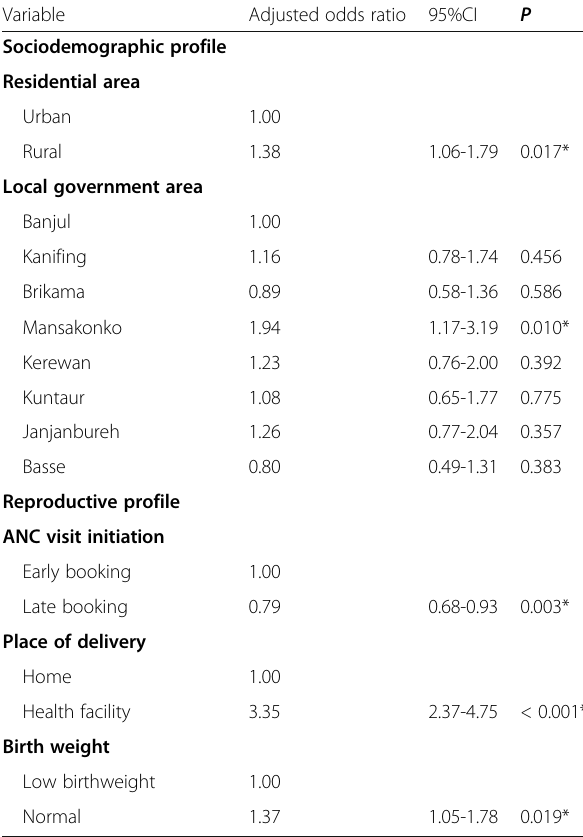
Table 2 Multivariable logistic regression of the determinants of mother and newborn skin-to-skin contact in The Gambia Variable